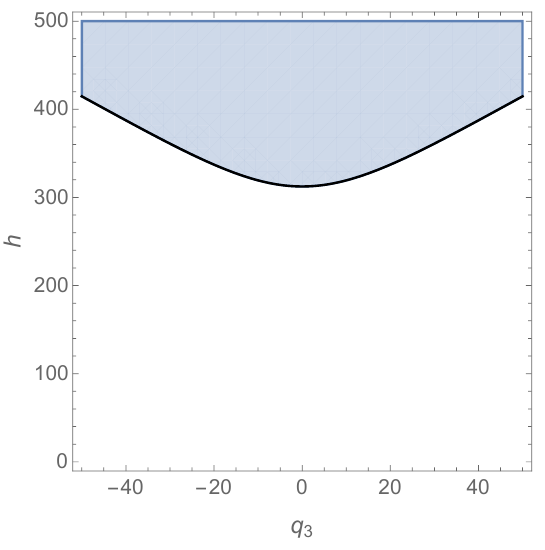
Figure 1 . Exclusion plot for W 3 , with c = 10 4 . The weight and charge ( h; q 3 ) of all primaries must fall in the shaded region, where (cid:20) 2 >